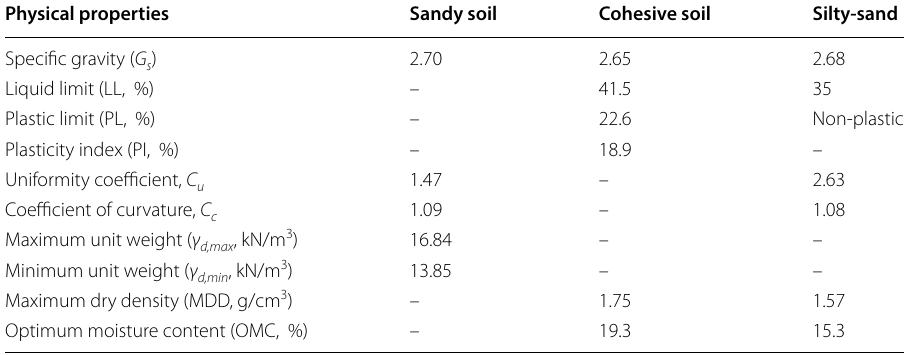
Table 1 Physical properties of the soils used in the present study Physical